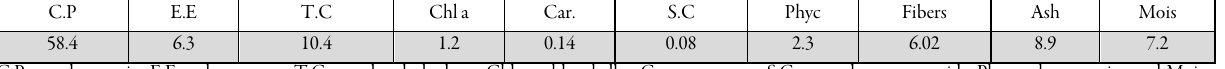
Table 5. Chemical composition of the outdoor produced Spirulina platensis